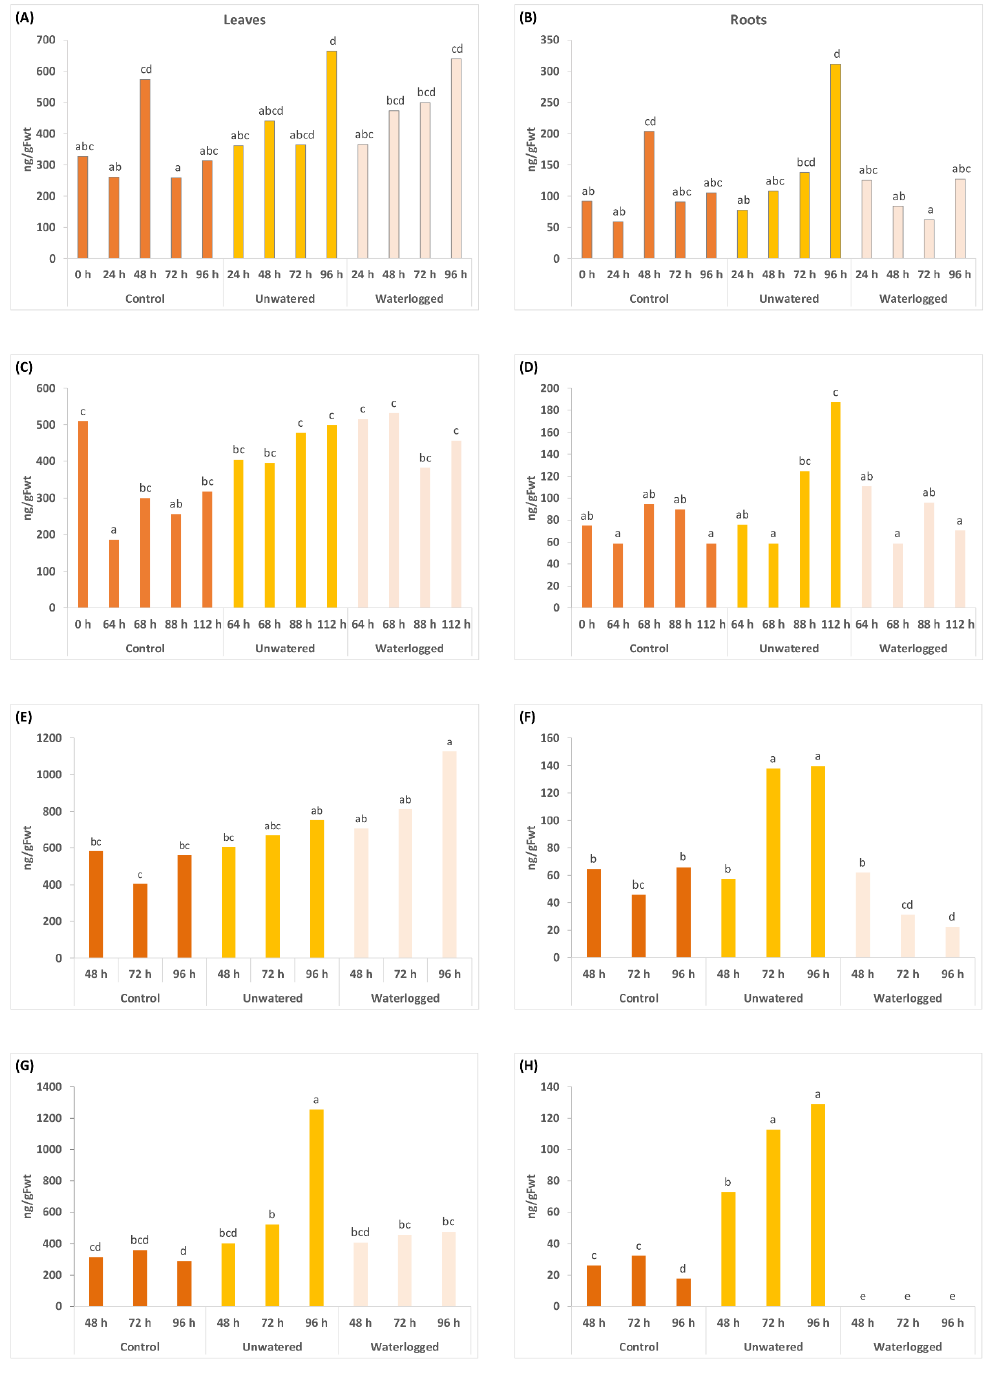
Figure 2. Dihydrophaseic acid (DPA) concentrations measured in leaves (left panel) and roots (right panel) at various sample times (in hours, shown in the x-axes) after application of three treatments. From time 0 h, plants in the unwatered treatment were not watered and waterlogged plants were subjected to constant water at quarter pot height. Plants in the control treatment received the standard watering regime of 12 min, twice daily. There were five replicate plants/time/treatment. Two separate experiments were carried out in 2020 on Actinidia chinensis var. chinensis ‘Zesy002’ plants over a 96 h treatment period as shown in ( A , B ), and 112 h ( C , D ). In 2021, another two experiments were carried out using an identical setup to compare responses between ‘Zesy002’ ( E , F ), and A . chinensis var. deliciosa ‘Hayward’ ( G , H ). Different lettering over the bars indicates statistically significant differences, as shown by LSD, p ≤ 0.05, within each separate experiment and tissue